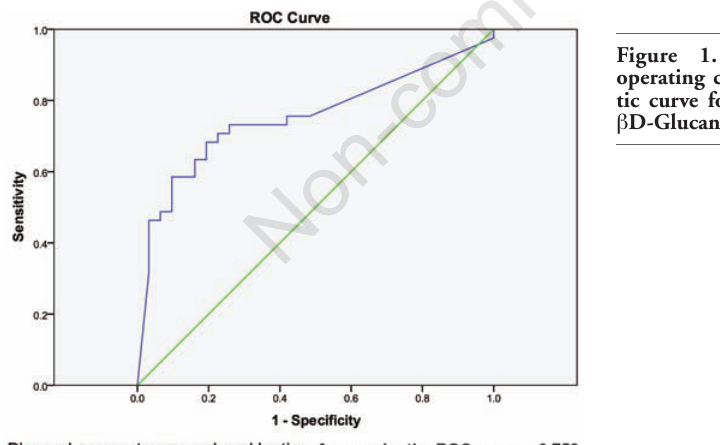
Figure 1. Receiver operating characteris- tic curve for the 1,3- b D-Glucan